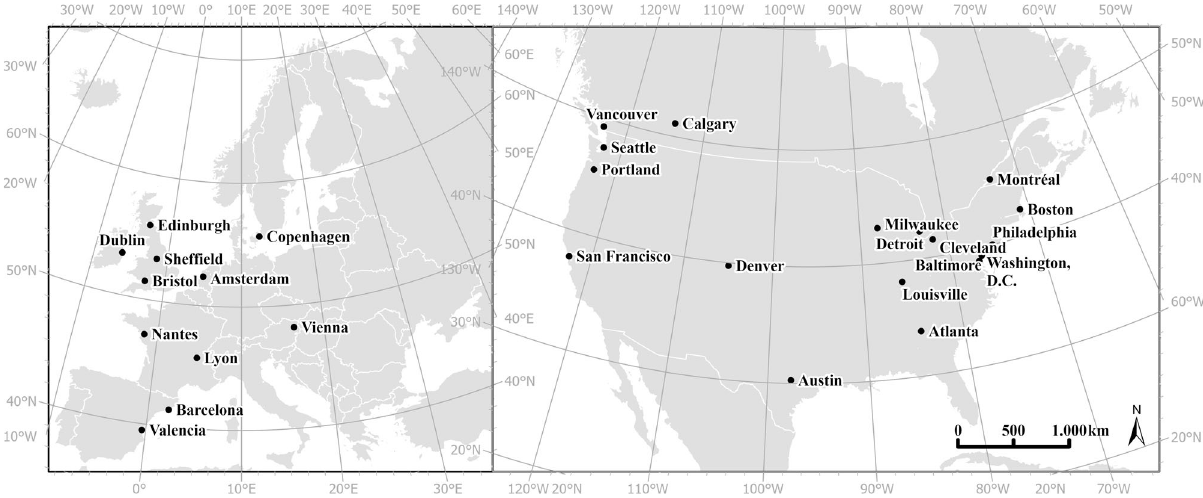
Fig. 1 Locations of the 28 cities included in the analysis. The cities analyzed here (labeled with points) are all mid-sized (500,000 - 1,500,000 population) and are located in 9 countries across Western Europe and North America. Cities were primarily selected to provide a diversity of geographic and growth